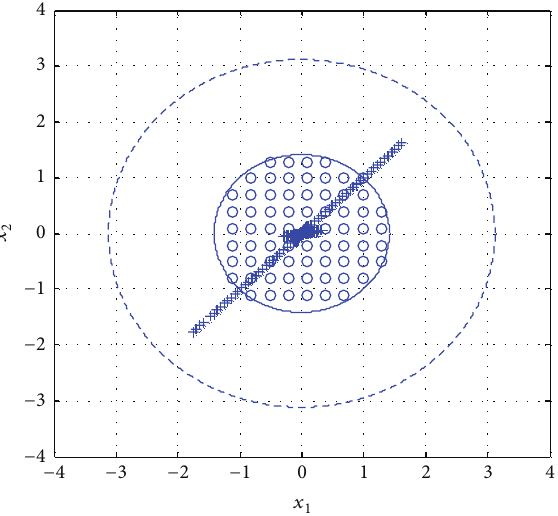
Figure 3: State response and minimum bound by Theorem